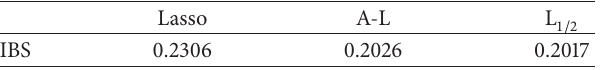
Table 3: The integrated Brier score (IBS) obtained by the Lasso, the adaptive Lasso and the adaptive L 1/2 shooting regularization method for DLBCL dataset. (Lasso: the Lasso method; A-L: the adaptive Lasso method; L 1/2 : the adaptive L 1/2 shooting regulariza- tion